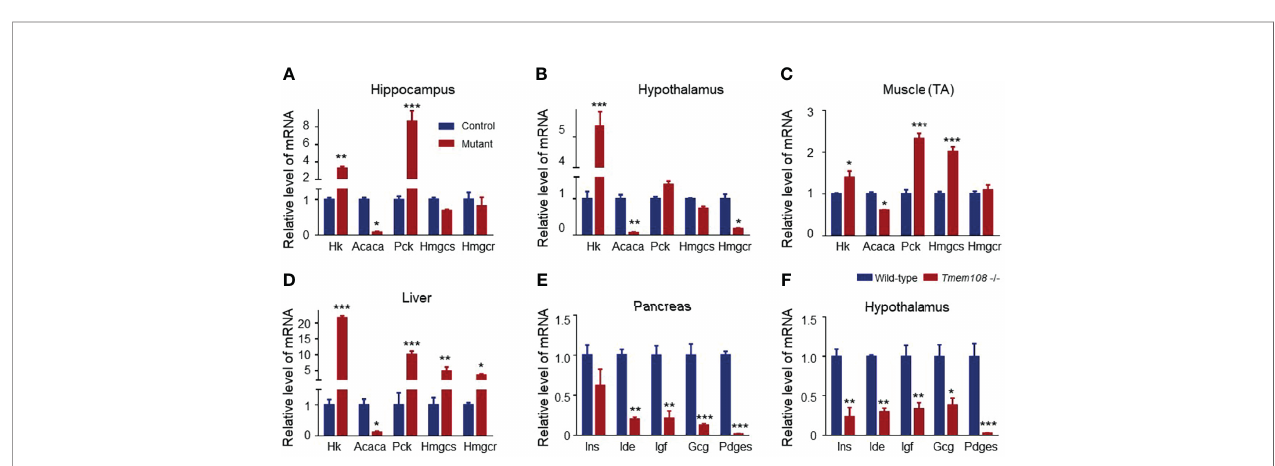
FIGURE 4 | Expression pro fi le of the metabolic and hormone genes in Tmem108 de fi ciency mice. (A – D) The glycolytic and lipogenic gene relative expression in several tissues was quali fi ed by Real-time PCR, including the hippocampus (A) , hypothalamus (B) , tibialis anterior (TA) muscle (C) , and Liver (D) , with Gapdh as the internal control. Hk increased, and Acaca decreased in the detected tissues of the mutant mice ( Tmem108 -/-), wild-type mice as the control. (E, F) . The hormone gene is related to metabolism in the pancreas (E) and hypothalamus (F) . Most of the detected hormone gene mRNA levels decreased in the mutant mice. (n = 5 per group, male mice; total RNA from each mouse tissue was pooled to generate cDNA. Data are represented as means ± SEM; two-way ANOVA Sidak ’ s multiple comparisons test, *p < 0.05, **p < 0.01, ***p < 0.001).